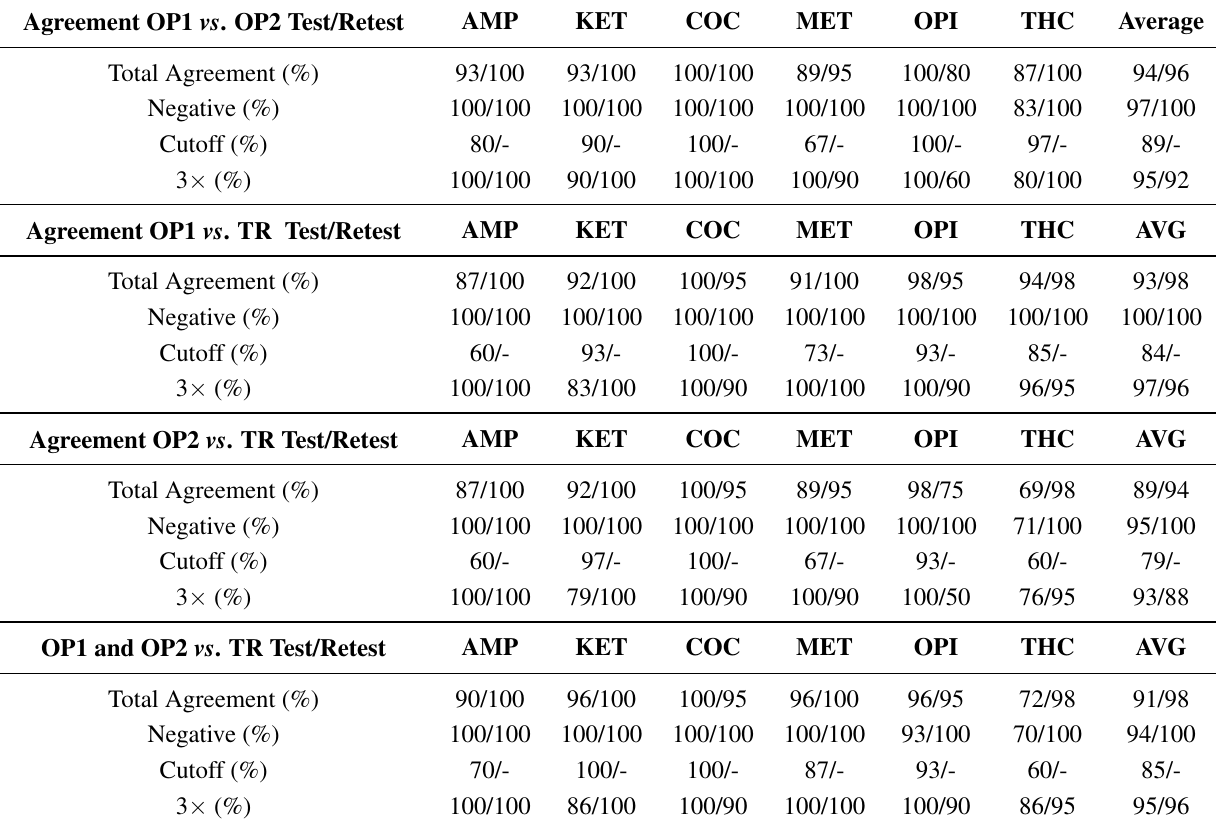
Table 5. Agreement test results summary. OP, operator. TR, test